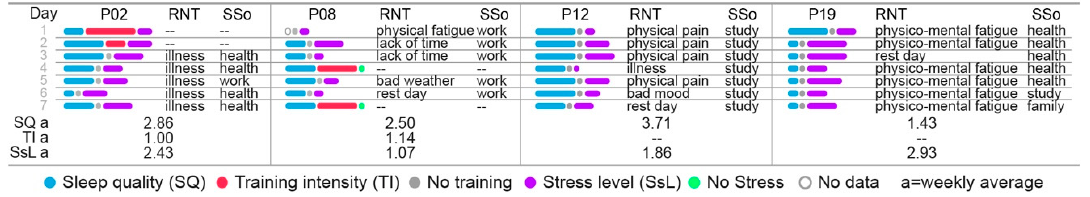
Figure 4. Evident heterogeneity of motives and causes for training behavior among and within